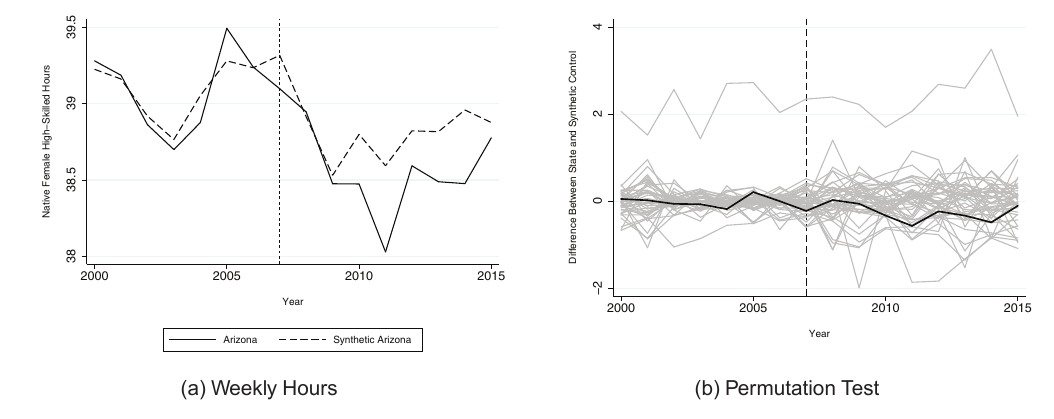
Figure 4 Native high-skilled female weekly hours (hours > 0)